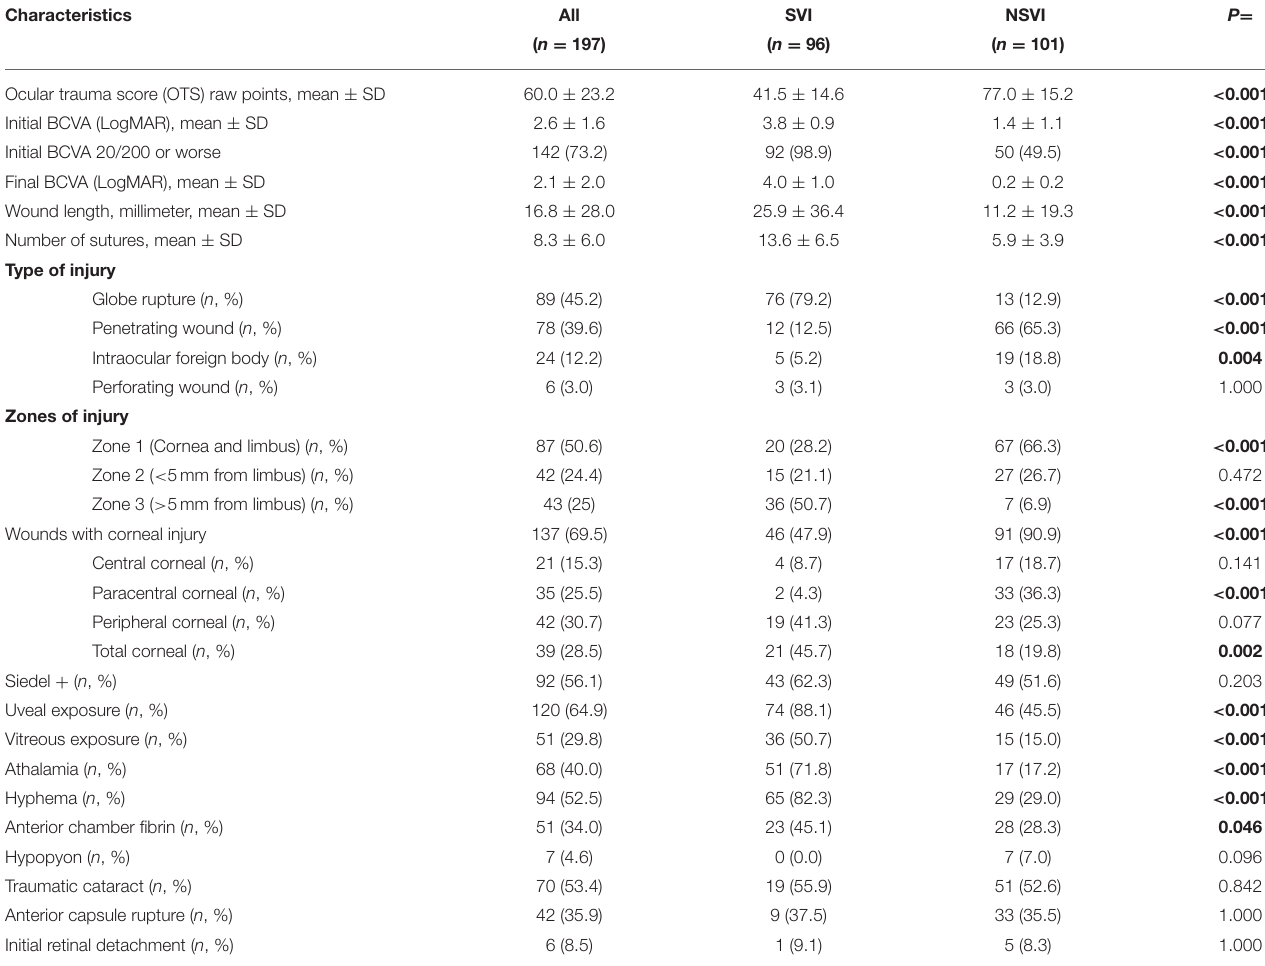
TABLE 2 | Clinical characteristics of the OGIs in SVI and NSVI patients.